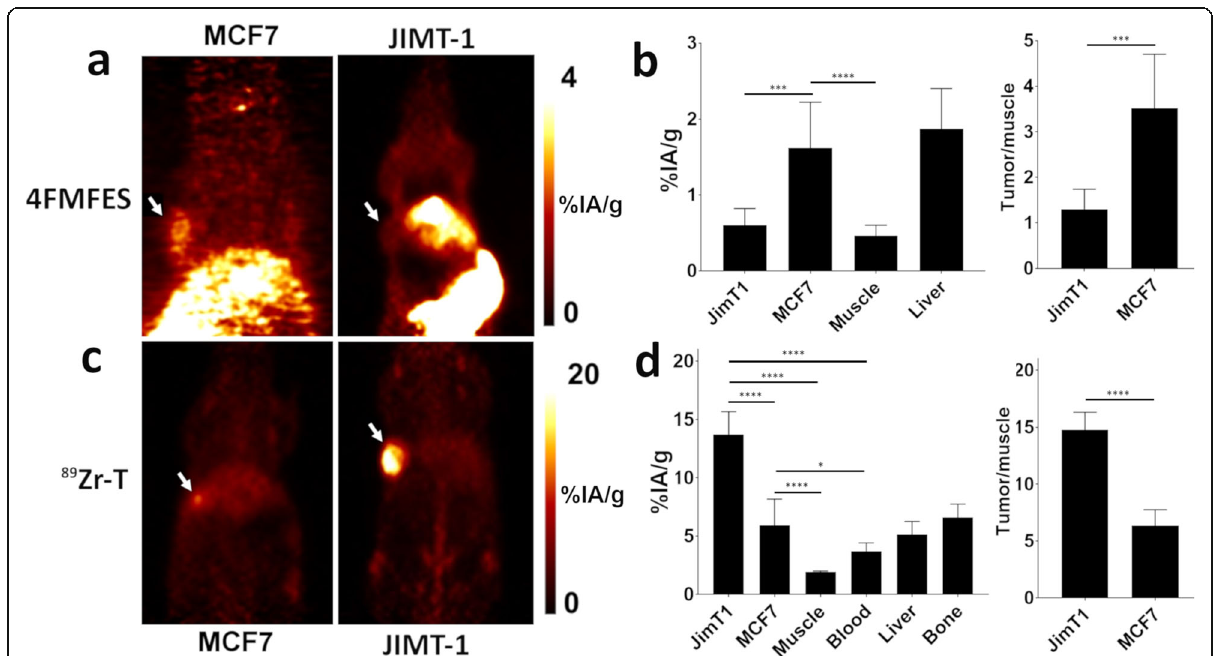
Fig. 4 Sequential 4FMFES and 89 Zr-T PET imaging in an orthotopic MCF-7 or JIMT-1 mouse model. a Representative coronal slices of 4FMFES- injected mice bearing either MCF-7 at 45 min p.i. or JIMT-1 tumors (white arrows). b 4FMFES PET-derived uptake reported in %IA/g of relevant organs and tumor-to-muscle ratios for each tumor type. c Representative coronal slices of 89 Zr-T at 144 h p.i. of MCF-7 or JIMT-1 tumor-bearing mice (white arrows). d 89 Zr-T PET-derived uptake of relevant organs in %IA/g and tumor-to-muscle ratios for each tumor type. * p < 0.05; *** p < 0.005; **** p <